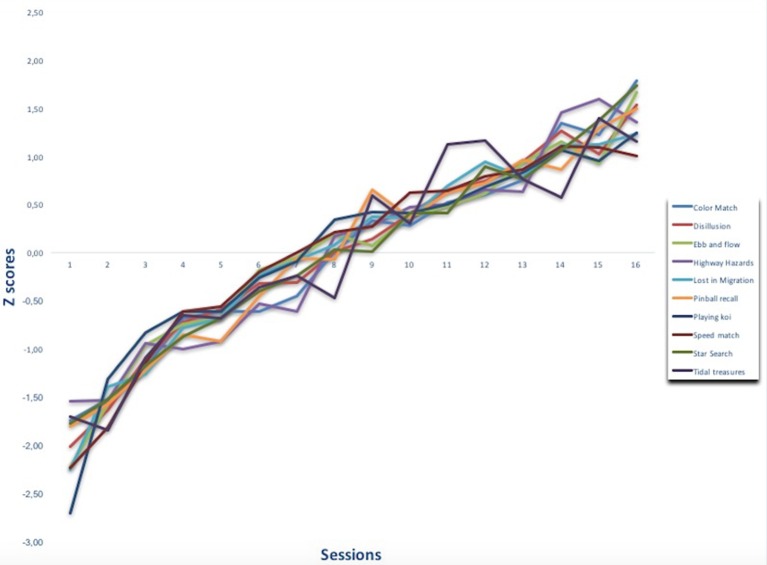
Average performance scores obtained in each video game across the training sessions in Z scores (mean 0; standard deviation 1).